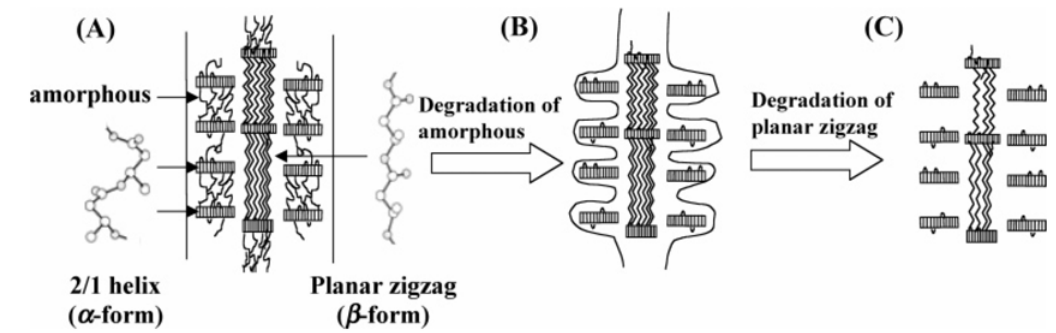
Figure 14. Schematic display of enzymatic degradation behavior of P(3HB) fibers with two kinds of molecular conformations: α -form (2 helix conformation) and β -form (planar 1 zigzag conformation) [83]. Reproduced with permission from Iwata et al ., Macromolecules ; published by ACS,